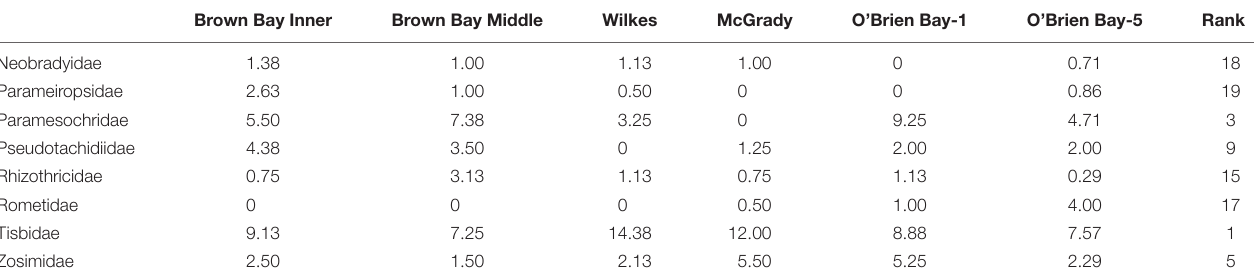
communities (largest estimated component of variation,